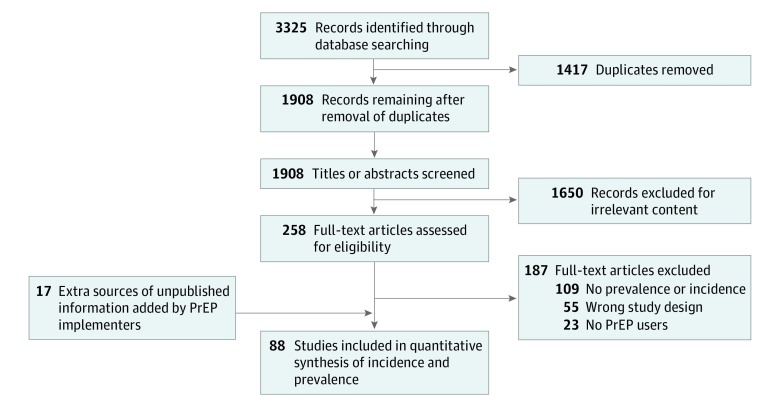
PRISMA FlowchartPrEP indicates preexposure prophylaxis.